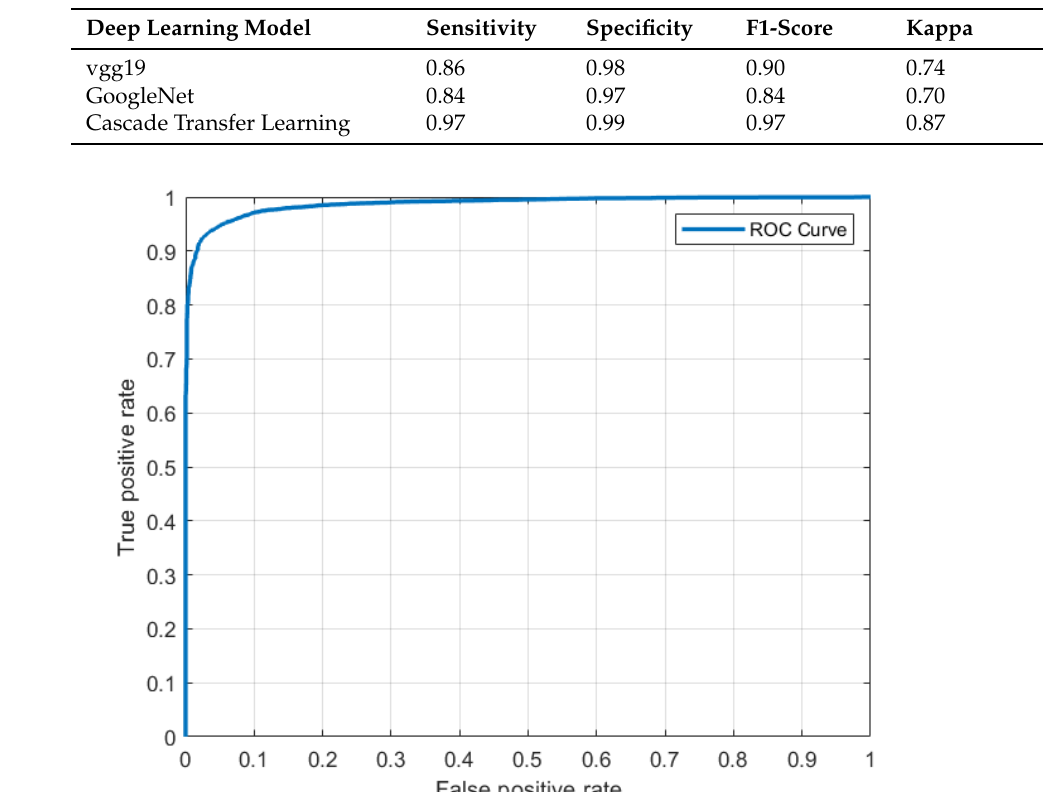
Table 2. Experimental results with different pre-trained models on SARS-CoV-2 dataset.